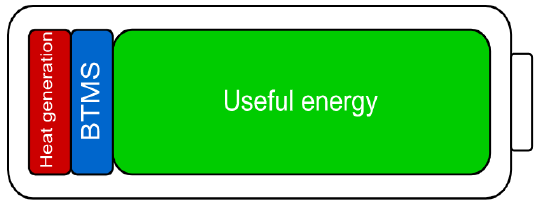
Figure 5. Energy portions distribution in a cycle.